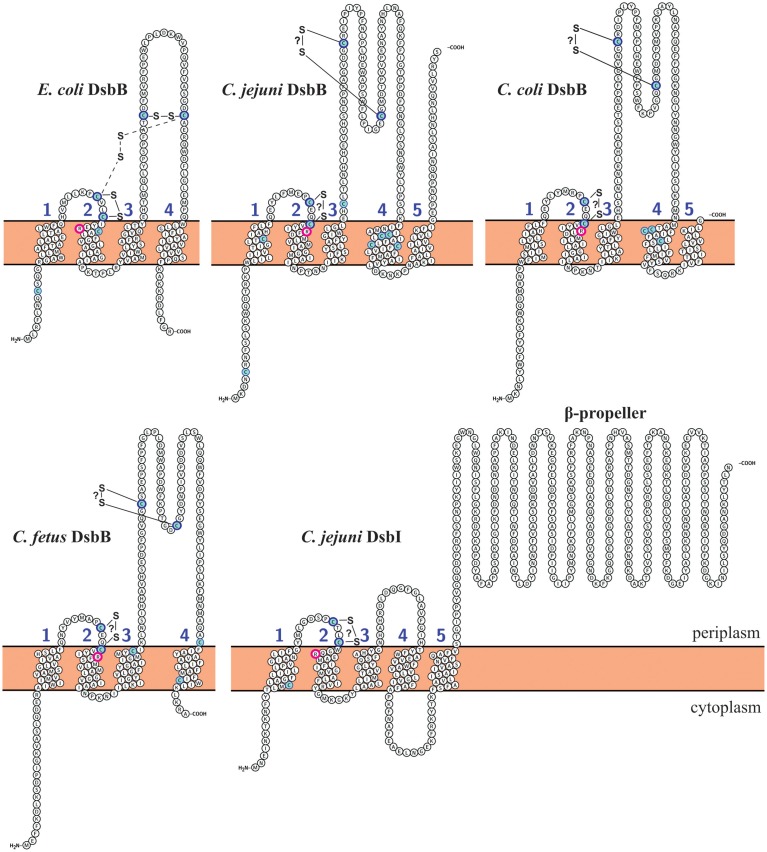
DsbB and DsbI topological model predictions for
Campylobacter
species and comparison with EcDsbB (E. coli). C. jejuni DsbI model is identical as C. lari DsbI1, DsbI2, and H. pylori DsbI. Transmembrane topology predictions of DsbB and DsbI proteins were determined using Protter (http://wlab.ethz.ch/protter/#) (Omasits et al., 2014). Predictions were confirmed with TOPCONS (http://topcons.cbr.su.se/) (Bernsel et al., 2008, 2009; Viklund et al., 2008), PSIPRED (http://bioinf.cs.ucl.ac.uk/psipred/) (Buchan et al., 2013) and PredictProtein (http://predictprotein.org) (Rost et al., 2004). Disulfide bonding patterns were predicted using DiANNA software (http://clavius.bc.edu/~clotelab/cgi-bin/DiANNA/DiANNA.py) (Ferre and Clote, 2005). Cysteine residues are marked with blue. Conserved arginine residues are circled with pink. Intermediate disulfide bond between Cys41 and Cys140 in EcDsbB is mark with dashed lines. Disulfide bonds that are not confirmed experimentally are marked with question mark (?). All predictions were compared and manually corrected according to published data.